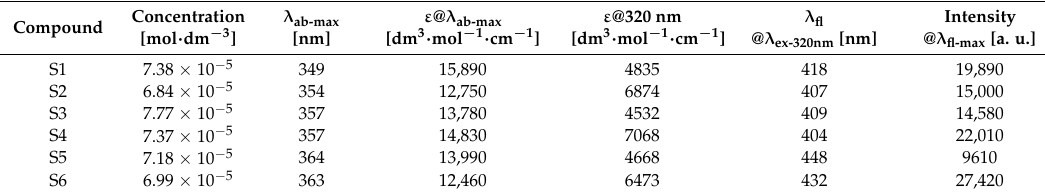
Table 2. Spectral characteristics of the 2-amino-4,6-diphenyl-pyridine-3-carbonitrile derivatives studied.